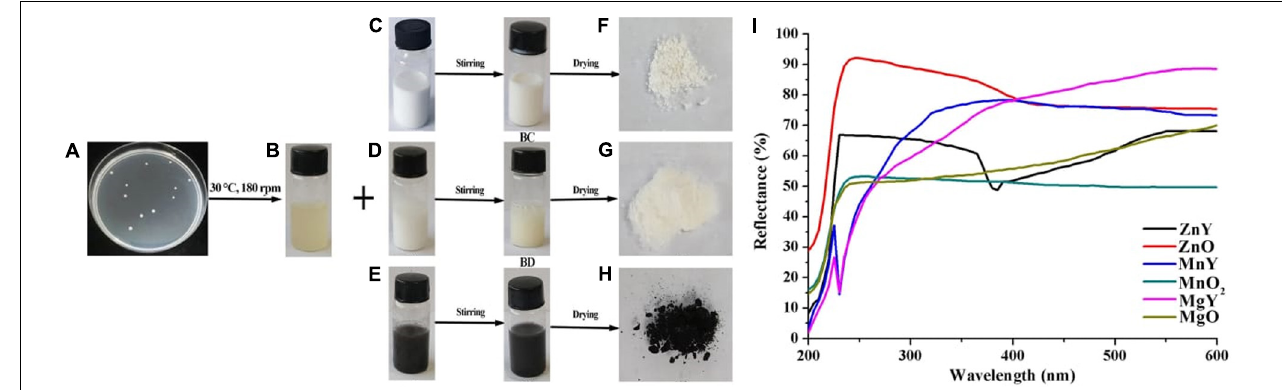
FIGURE 1 | Schematic presentations of synthesis of ZnO, MnO 2 , and MgO nanoparticles. (A) Colony of Paenibacillus polymyxa strain Sx3 (B) Supernatant of P. polymyxa strain Sx3 (C) ZnO solution (D) MgO solution (E) MnO 2 . solution (B,C) ZnO nanoparticles (B,D) MgO nanoparticles (B,E) MnO 2 nanoparticles (F)